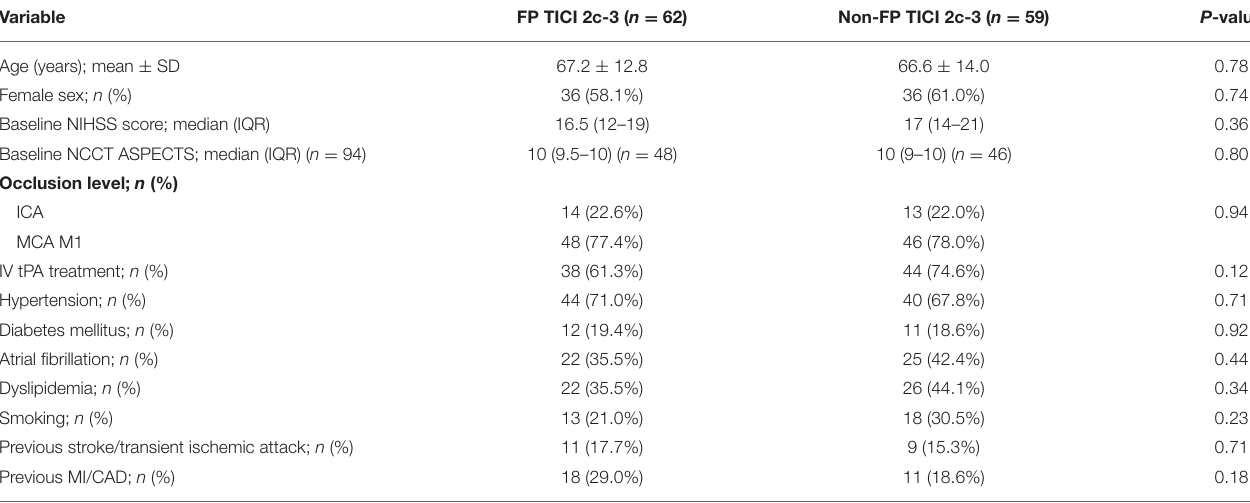
TABLE 3 | Comparison of baseline variables between first-pass TICI 2c-3 vs. non-first-pass TICI 2c-3.